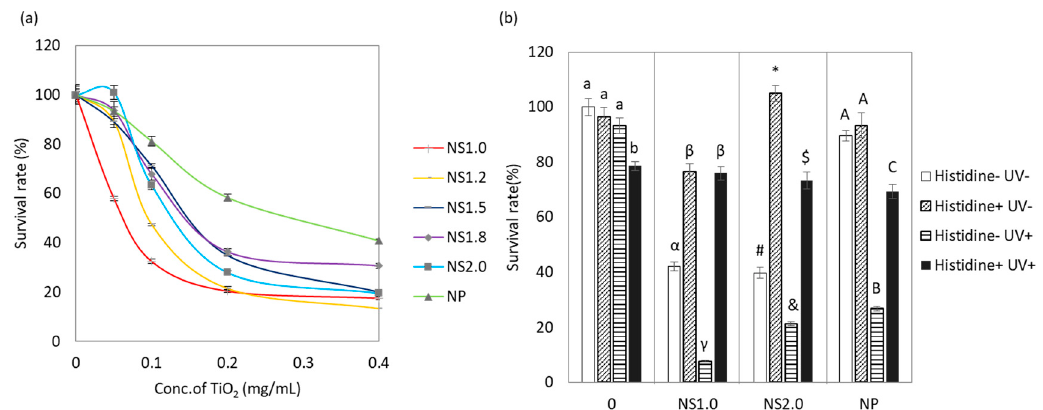
Figure 3. Antibacterial property of TiO 2 nanosheet. ( a ) The survival rate of S. mutans cultured with TiO 2 NS and NP under UV irradiation. ( b ) Antioxidant effect on the survival rate of S. mutans cultured with NS1.0, 2.0, and NP in both the presence and absence of UV irradiation conditions. Different letters in the same material groups show significant differences ( p < 0.05).